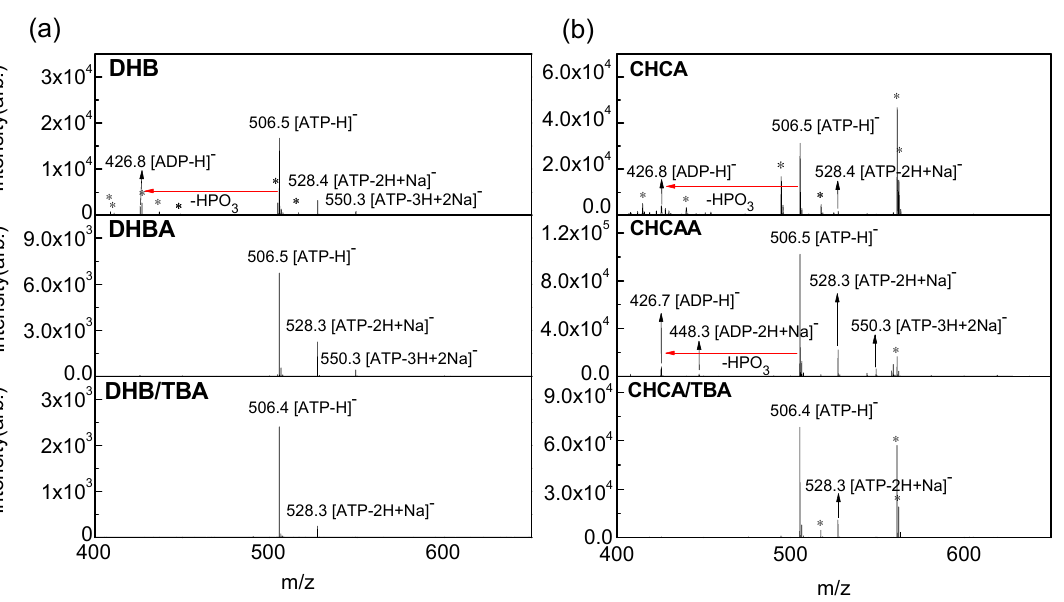
Figure 1. MALDI mass spectra of ATP (1 nmol) in one spot with the matrix of ( a ) DHB compared with DHBA, and DHB/TBA ILs and ( b ) CHCA compared with CHCAA and CHCA/TBA in a negative reflectron mode. The molar ratio of the matrix-to-analyte was approximately 500:1. The relative laser energy was 95% and 75% for each group, respectively. The star symbols denote the signals of the matrix background.